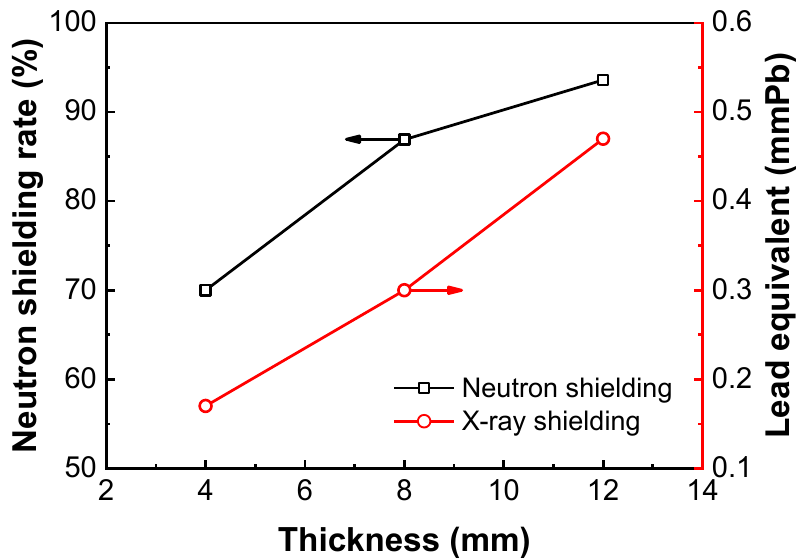
Figure 4. The radiation shielding properties of the metalized acrylic polymerized evaluated by lead equivalent thickness.